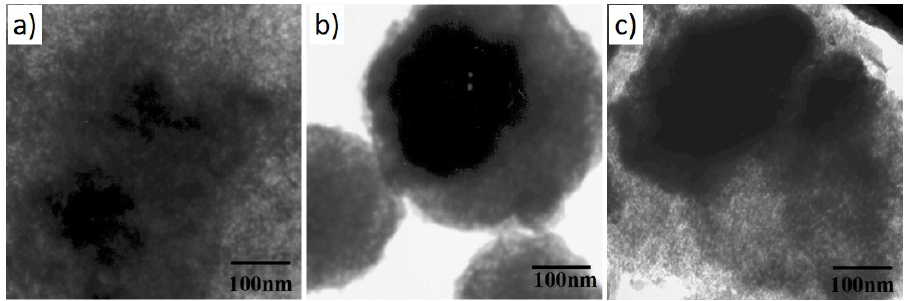
Figure 4. TEM images of Al 2 O 3 /SrCO 3 xerogels after annealing at 500 °C with various Sr/Al molar ratios: ( a ) 0.1, ( b ) 0.5, and ( c ) 1.0.